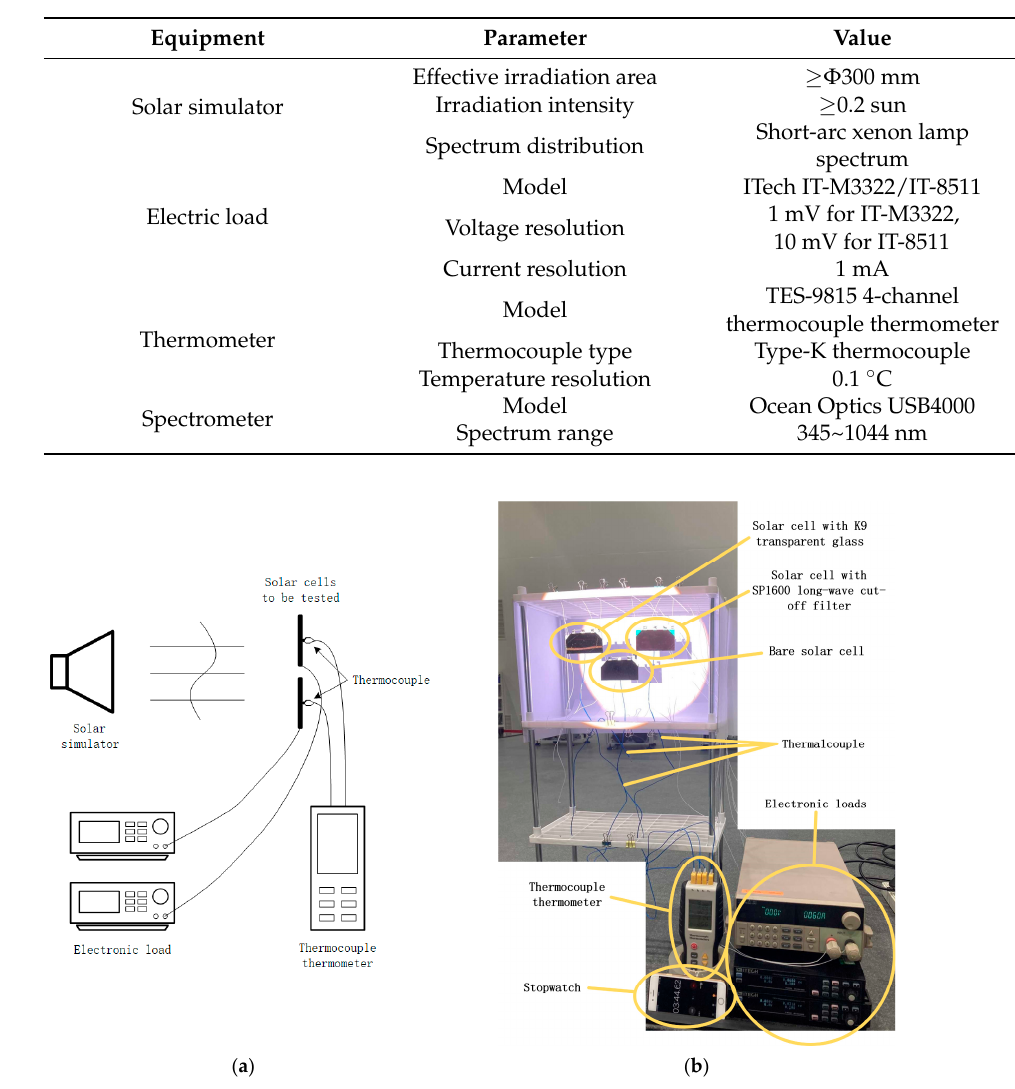
Figure 8. Temperature rise test setup. ( a ) Test setup diagram. ( b ) Real test setup.